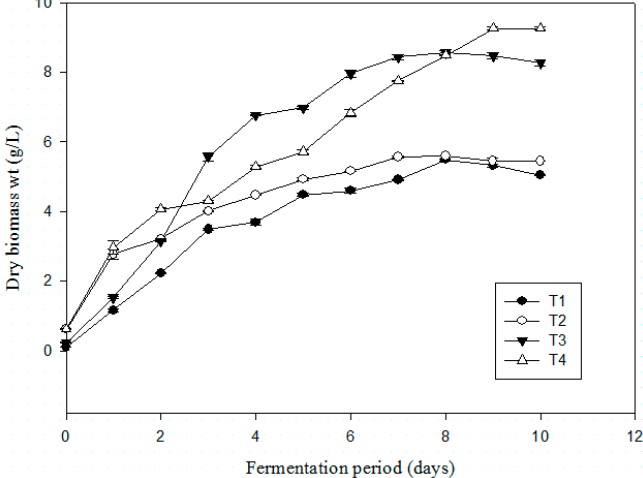
Figure 3. Effect of different levels of sea salts concentration (0% (T1), 3.65% (T2), 6% (T3), 9% (T4)) on dry biomass weight for T. albobiverticillius 30548 (culture in PDB, 27 °C, initial pH 4.0, 200 rpm of agitation rate).